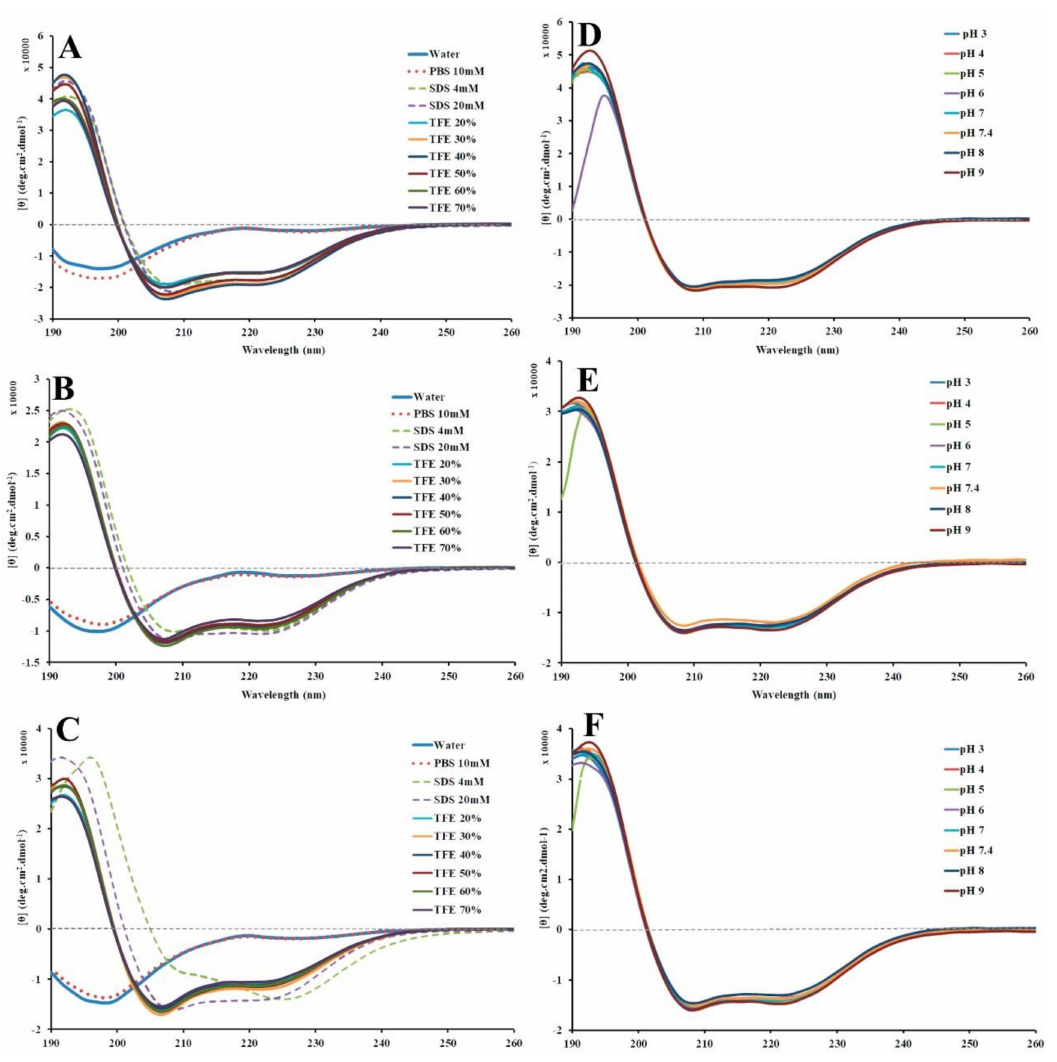
Figure 6. Secondary structure of the peptides evaluated by circular dichroism. Peptides were evaluated in different solvents (Stigmurin— A , StigA25— B , and StigA31— C ) and also in different pH (3.0–9.0) in 20 mM SDS (Stigmurin— D , StigA25— E , and StigA31— F ). The analyses were performed in a JASCO J-810 spectropololarimeter at 25 ◦ C, with a 1 mm quartz cuvette, from 190 nm to 260 nm at a speed of 50 nm min − 1